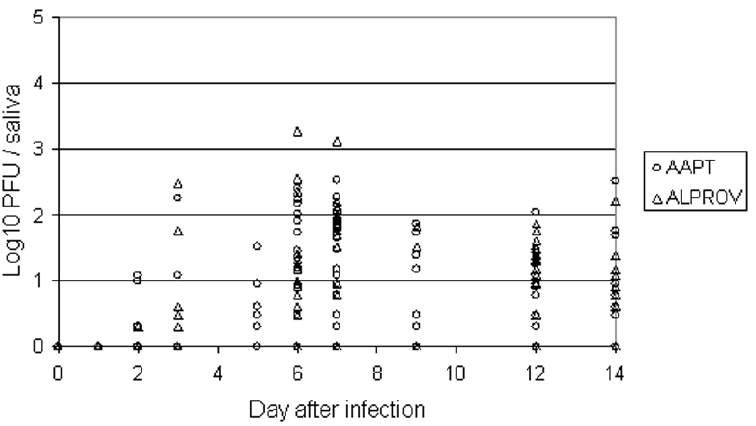
Figure 4. CHIKV present in saliva of Aedesalbopictus Providence (ALPROV) and Aedesaegypti Petite-Terre (AAPT). At different days after oral infection, transmission potential was assessed by estimating the number of infectious viral particles in excreted saliva by plaque assay on cell